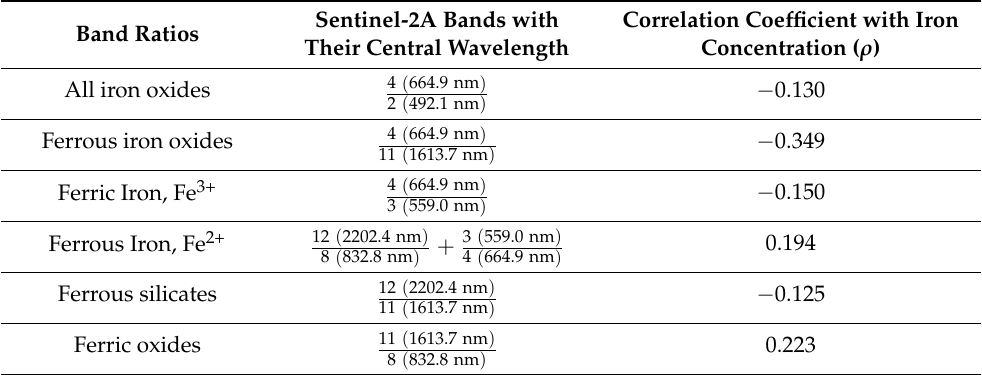
Table 1. Correlation coefficients between iron grades and band ratios of Sentinel-2 [30] at the sampling points. The highest correlation is in bold. Band